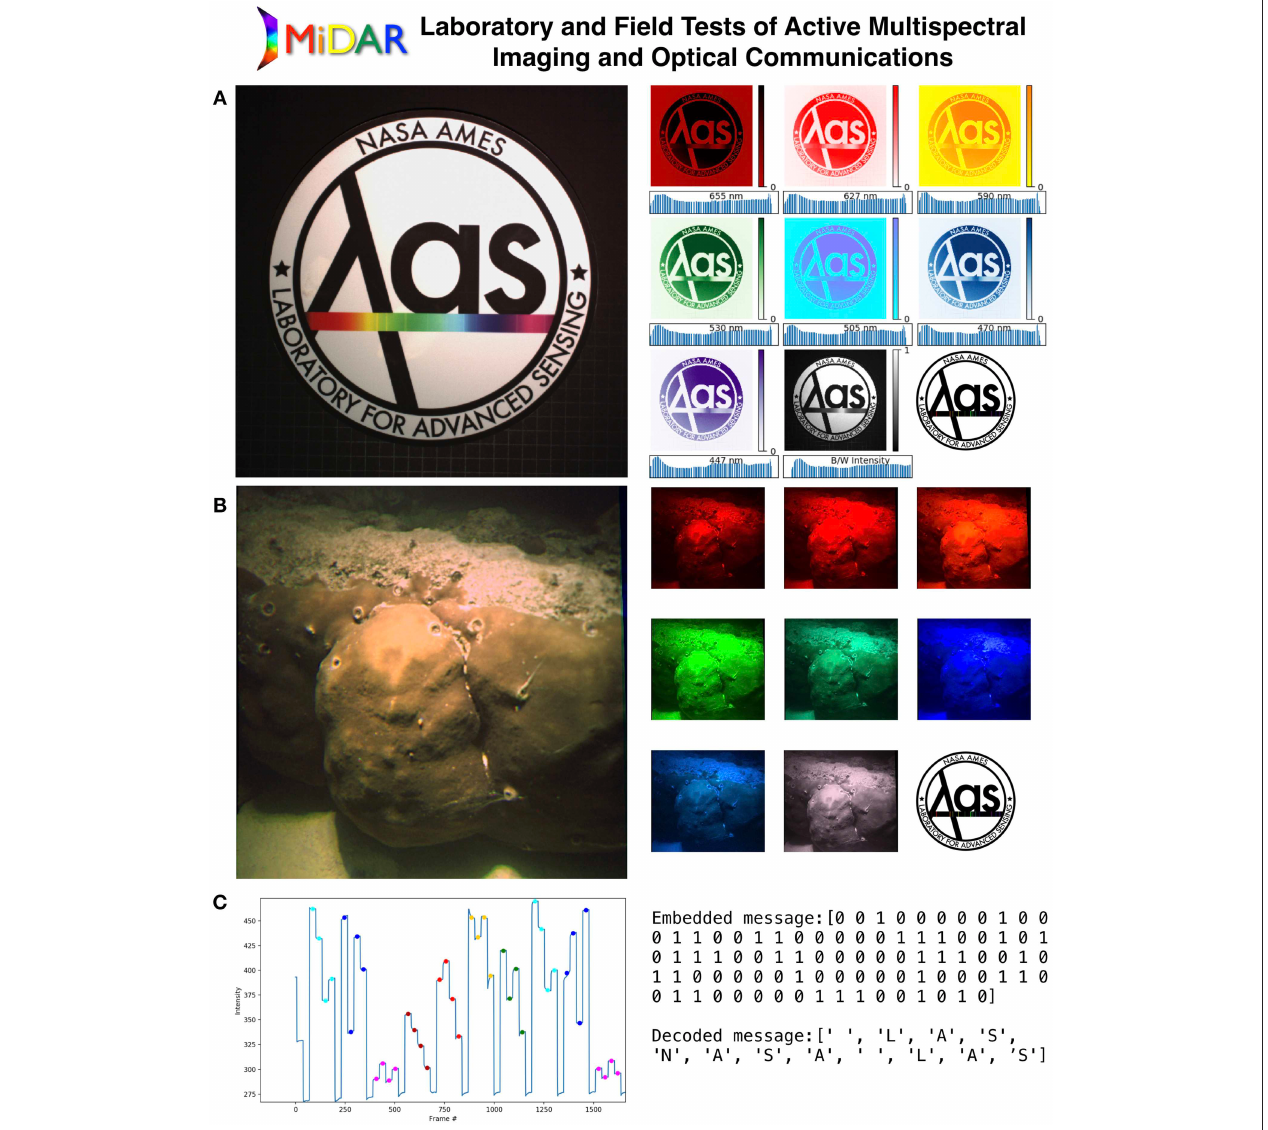
FIGURE 10 | MiDAR Laboratory and Field Tests of Active Multispectral Imaging and Optical Communications. (A) 7-Channel monostatic MiDAR imaging test on optical bench with multispectral test target. Here, half of the test target was illuminated with a broadband source to test MiDAR’s ability to determine active reflectance independent of ambient conditions. RGB image shown on left. Reflectance maps shown for each spectral band from 655 to 447nm on right. (B) The first 7-channel airborne MiDAR test over coral with an underwater MiDAR receiver from a 2018 field campaign in Guam. Here, MiDAR is operating in a bistatic configuration with a MiDAR transmitter above the surface, and a diver-mounted MiDAR receiver underwater. MiDAR resolves a Porites coral in the same seven multispectral bands as the optical bench test, and simultaneously performs simplex optical communication through the air-water interface. (C) Embedded MiDAR data transmission in coral image decodes a simple hidden